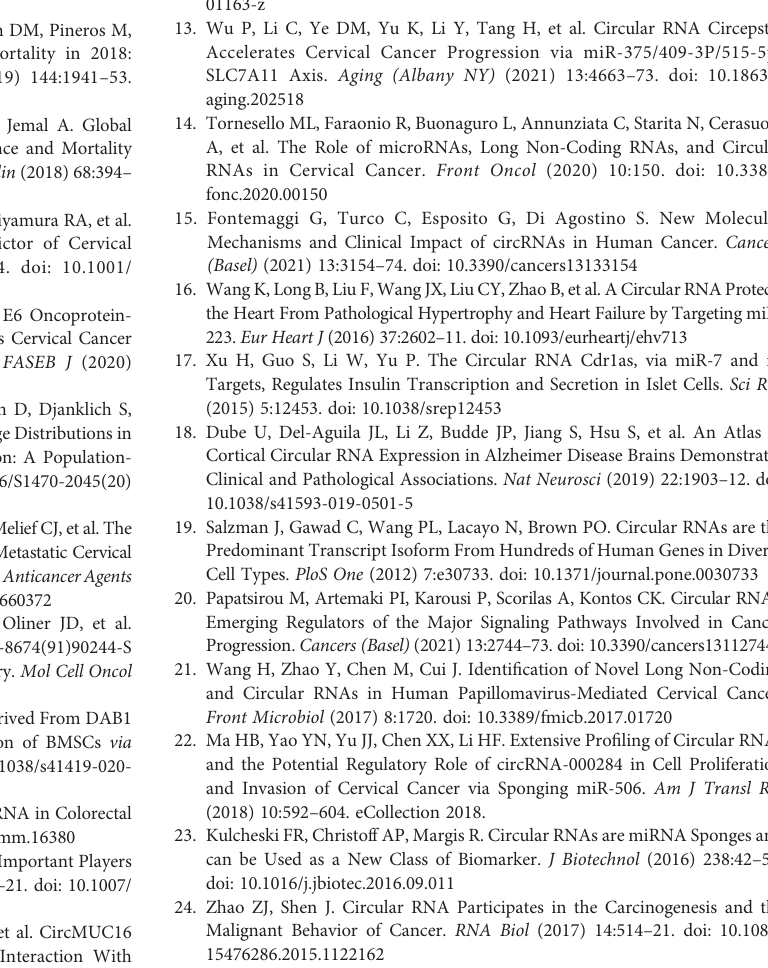
Supplementary Figure 1 | The high RCMs were identi fi ed through alignment of the intron 1 and intron 3 sequences with BLAST. Supplementary Figure 2 | ADAR1 and QKI did not regulate circLMO1 expression. Data from the GEPIA database showed that DHX9 level (A) was increased in cervical cancer tissues, ADAR1 level was unchanged (B) , and QKI level (C) was decreased in tumor tissues compared with normal control. qPCR analysis of circLMO1 and mLMO1 levels in C33A cells after ADAR1 or QKI knockdown (D) , and inCaSki cells after ADAR1 or QKI overexpression (E) . **p < 0.01. Supplementary Figure 3 | qPCR analysis of circLMO1 and miR-4291. (A) CaSki cells were treated with Lv-circLMO1 or Lv-cont and then circLMO1 expression was assessedusingqPCR. (B) C33A cellsweretreatedwithsiRNA-circLMO1 orsiRNA- control and then circLMO1 expression was assessed using qPCR. (C) C33A cells were treated with miR-4291 mimics or anti-miR-4291, and then miR-4291 expression was assessed using qPCR. **p< 0.01. Supplementary Figure 4 | ThepredictedtargetgeneofmiR-4291. (A) TargetScan7.1 tool was used to predict the target genes of miR-4291. There are 5084 genes possibly targetedbymiR-4291.Among5084genes, 3genes(ACSL4, PTGS2, andSLC7A11) are ferroptosis-related genes. (B) C33A and CaSki cells were treated with miR-4291 mimics and then the protein level of Slc7a11 and Ptgs2 was assessed using western blot. (C) C33A and CaSki cells were treated with anti-miR-4291 and then the protein level of Slc7a11 and Ptgs2 was assessed using western